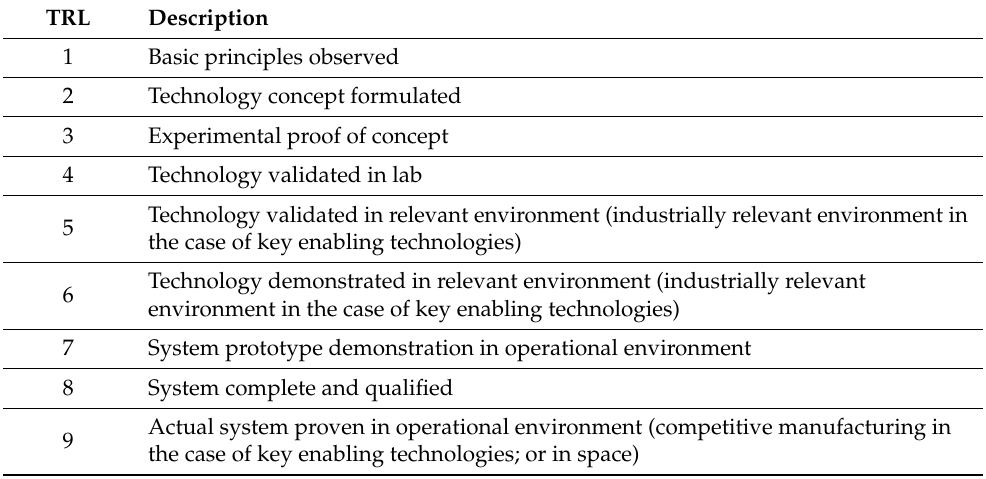
Table 2. Technology readiness levels (TRL)